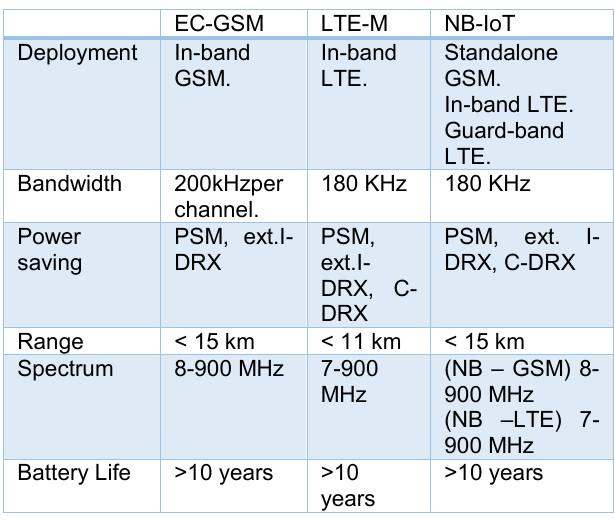
TABLE 3 COMPARISON OF 3GPP IOT PROPOSALS